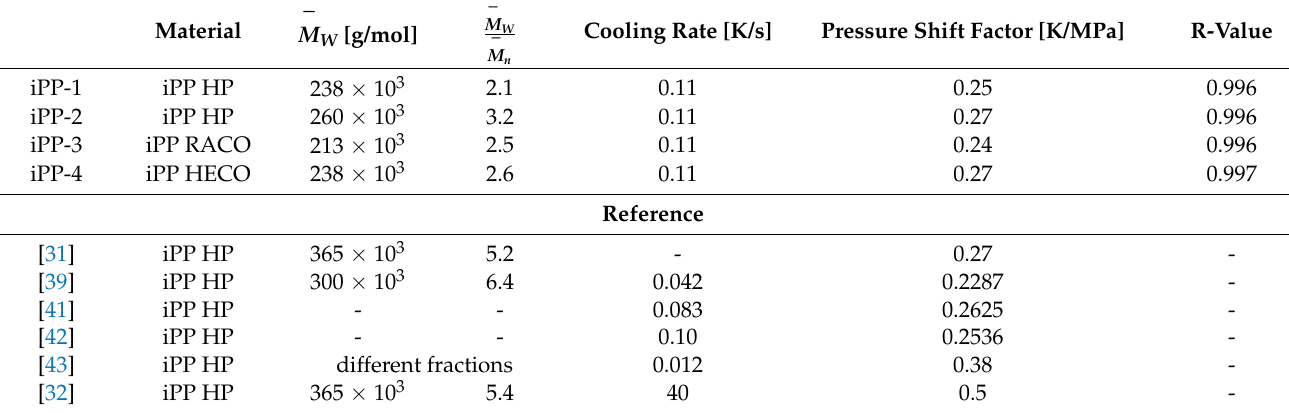
Figure 3. Pressure-dependent crystallization temperature determined from the pvT-curves. Table 2. Linear pressure-dependent shift factor, dependent on molecular weight MW, polydispersity and cooling rate— comparison literature review and own investigations. (polydispersity is the quotient of the weight average M W and the number average M n of the molecular weight).